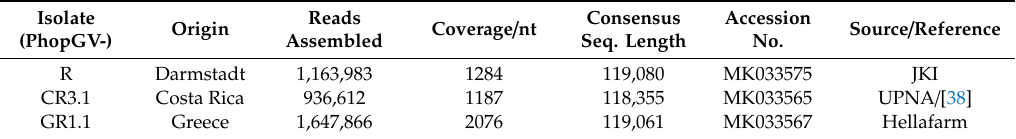
Table 1. Characteristics of consensus sequence (>50% majority) of the sequenced genomes of the PhopGV-R isolate and two additional PhopGV isolates used for this study.